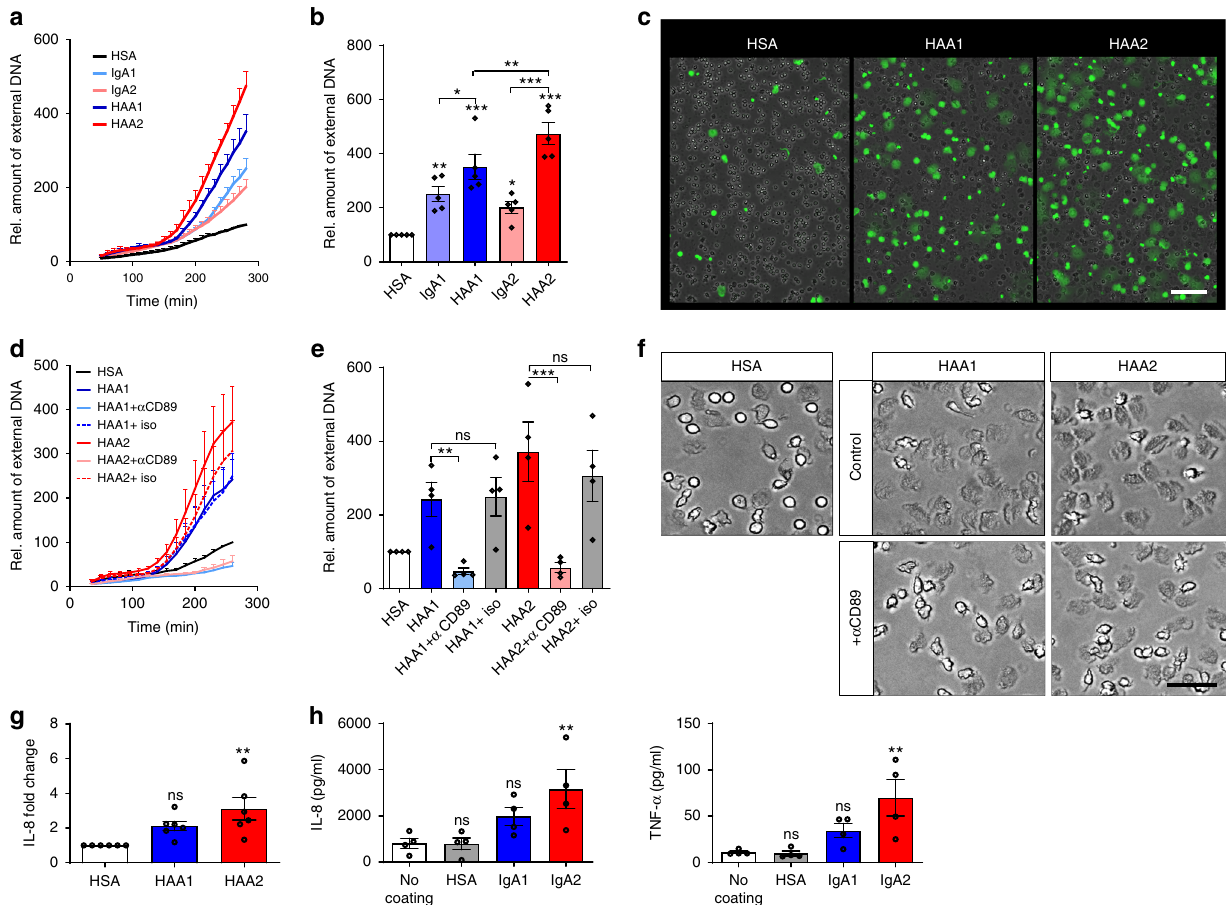
Fig. 1 IgA2 activates neutrophils and macrophages more potently than IgA1. a – c Human neutrophils were stimulated with 200 µ g/ml of monomeric or heat aggregated ( = HAA) IgA1 and IgA2, or with human serum albumin (HSA). Neutrophil extracellular trap (NET) formation was evaluated by staining extracellular DNA with Sytox Green. a NET formation over time. b Relative amount of extracellular DNA at 280 min after stimulation normalized on HSA treatment; n = 5 donors. c Representative images at 280 min after stimulation. Scale bar = 50 µ m. d – f NET formation of human neutrophils with 200 µ g/ml HAA1 or HAA2 in the presence of 10 µ g/ml blocking antibody against Fc α RI ( = α CD89) or isotype control ( = iso). d NET formation over time. e Relative amount of extracellular DNA at 260 min after stimulation normalized on HSA treatment; n = 4 donors. f Representative images at 35 min after stimulation. Scale bar = 20 µ m. g IL-8 released by neutrophils 4 h after stimulation with HSA, HAA1, or HAA2; n = 6 donors. h Cytokines released by macrophages 6 h after seeding in wells coated with HSA, IgA1, or IgA2; n = 4 donors. Signi fi cances were tested with paired one-way ANOVA followed by Bonferroni correction for selected pairs of columns b , d or Dunnet ’ s correction g , h . * p < 0,05; ** p < 0,01; and *** p < 0,001. Data are presented as mean ± s.e.m. a , d or scatter blots with bars showing mean ± s.e.m. b , e , g , h . Source data are provided as a Source Data fi